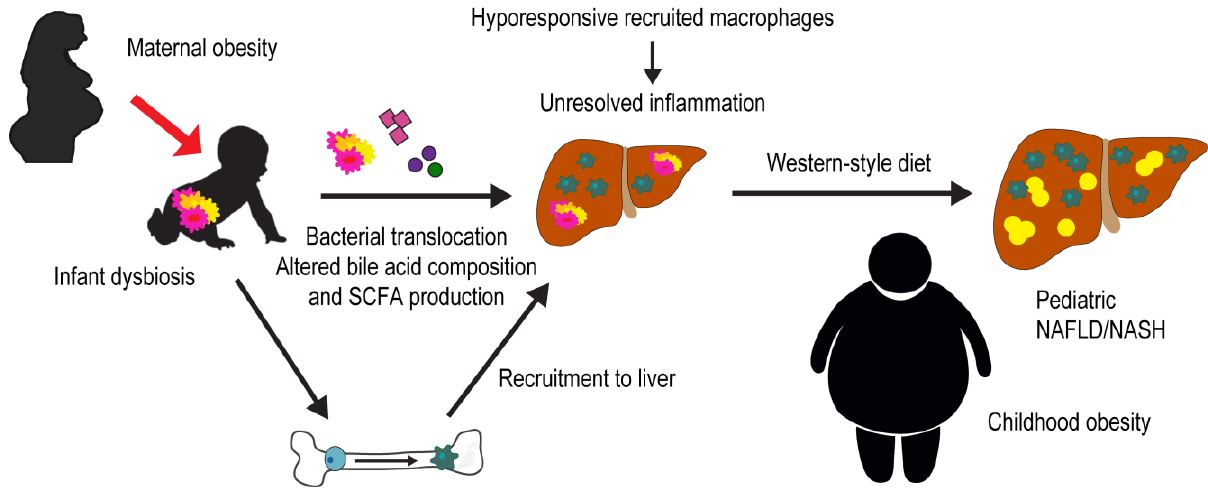
FIGURE 1: Proposed mechanism by which dysbiosis in infants of obese mothers predisposes offspring to non-alcoholic fatty liver disease (NAFLD) and obesity. Altered gut microbes in the infant of an obese mother cause altered bile acid metabolism, increased short-chain fatty acid production and a leaky gut with bacterial translocation. In the bone, infant dysbiosis results in poorly functioning recruited mac- rophages. In the liver, the inflammation caused by translocated bacteria remains unresolved due to hyporesponsive recruited macrophag- es. Exposure to a secondary hit, such as a Western-style diet, results in hepatic steatosis and